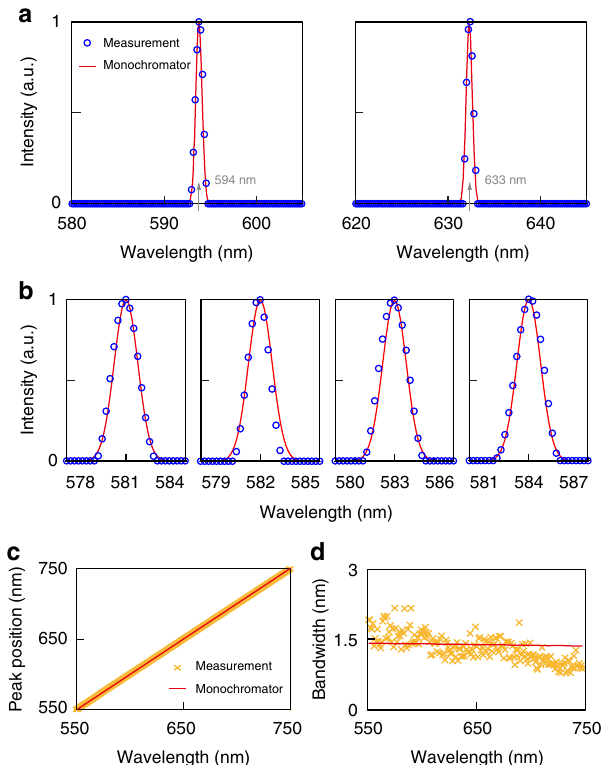
Fig. 4 Resolution test. a Measurements of the emission spectra of two HeNe lasers at 594 and 633nm, respectively. The reconstructed spectra (circles) match well with the reference spectra (red solid line). The average measured linewidth is around 1nm. b The PC spectrometer is used to measure the spectra of narrow-band light generated by the monochromator at 581, 582, 583, and 584nm, respectively. The circles are results from the PC spectrometer. The red solid line is the ground-truth reference based on speci fi cation of the monochromator. c Comparison of 201 measured peak positions (from 550 to 750nm, with 1nm separation) with their ground-truth. d Comparison of the measured linewidths with the speci fi cation of